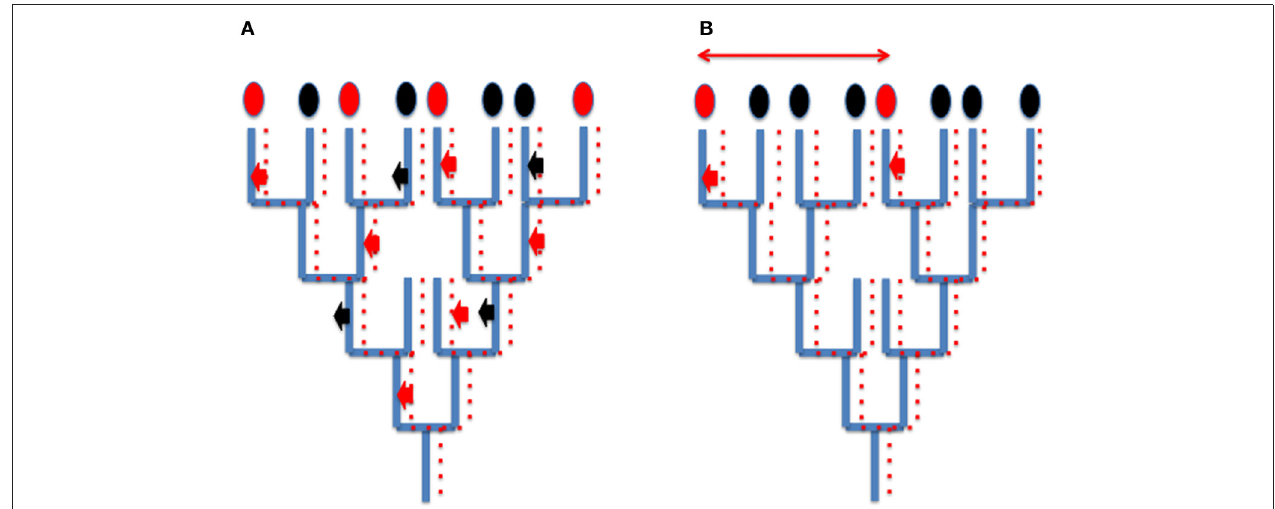
FIGURE 2 | How integration of viruses or related elements can confuse phylogenetic analyses? (A) Patchy phylogenetic distribution of viral genes in cellular genomes. A tree of organisms (blue lines) and a co-evolving viral (plasmid) lineages (dotted red lines). A viral (plasmid) gene is sometimes integrated (red arrow) sometimes loss (black arrows) from cellular genomes. The encoded viral proteins will appear as characters